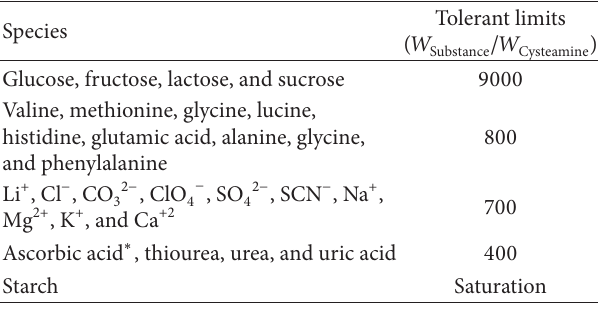
Table 1: Interference study for the determination of 10.0 𝜇 M cysteamine under the optimized conditions.